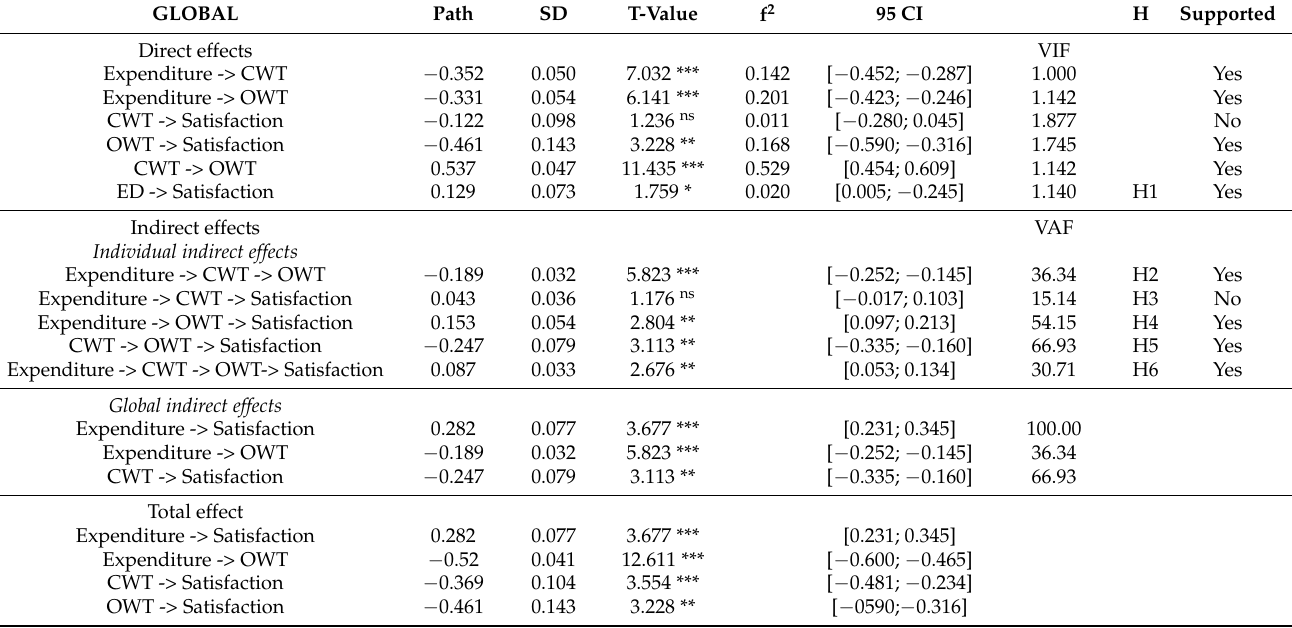
Table 6. Assessment of the global structural